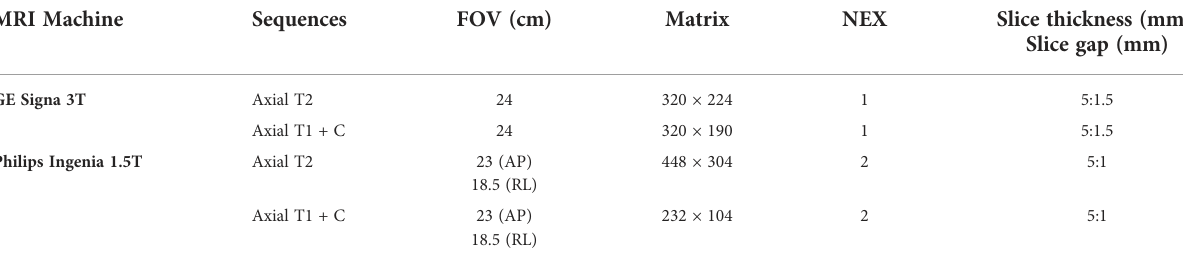
TABLE 1 MR image acquisition